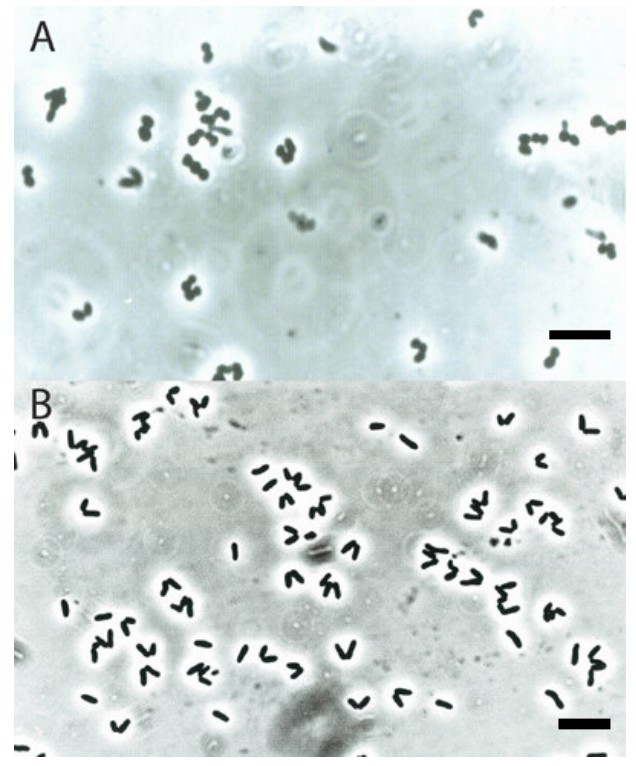
FIGURE 6. Phase contrast micrographs displaying the cell morphology of the w-t when the cells were grown on benzene (A, coccoid shape) or on mannitol (B, thick rods). Bar = 5